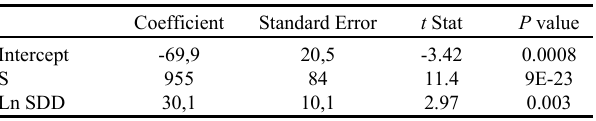
Table 1. Regression analysis